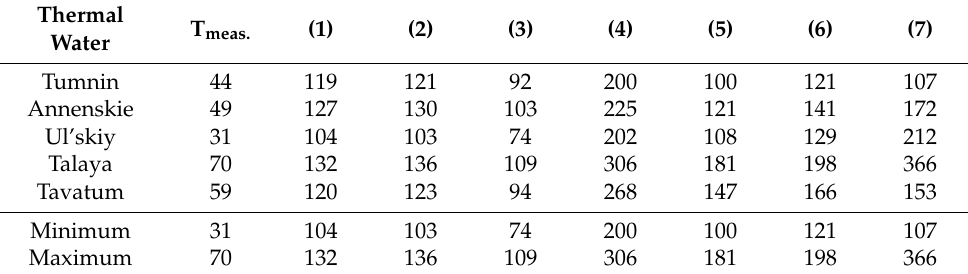
Table 2. The results of the reservoir temperature calculations, ◦